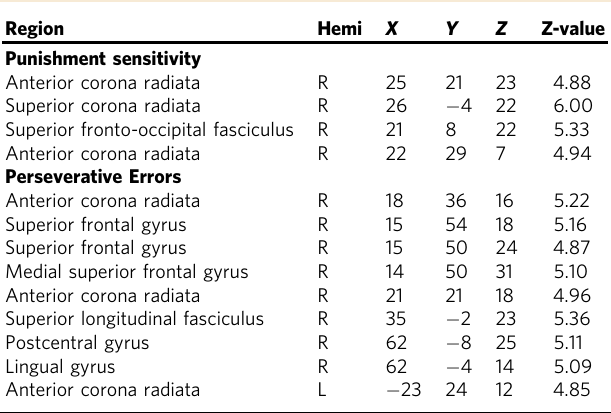
Table 3 MNI coordinates of peak voxels for different VLSM analyses Region Hemi X Y Z-value Punishment sensitivity Anterior corona radiata